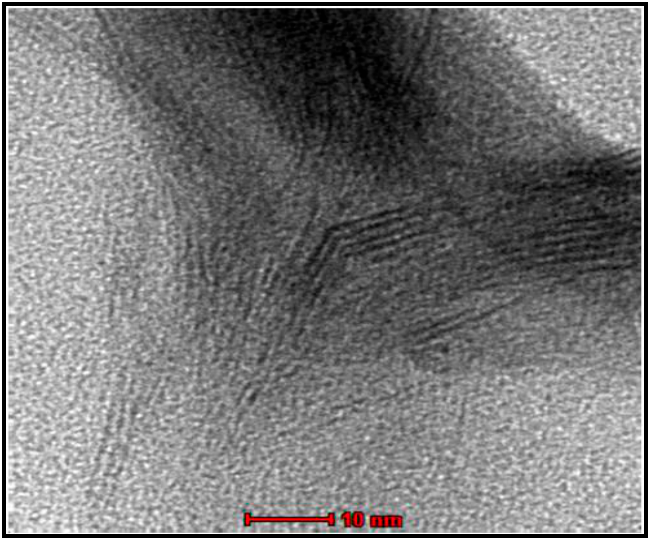
Figure 5. Transmission electron microscopy (TEM) image of PET hybrid containing 1% weight of clay APO9A:P.